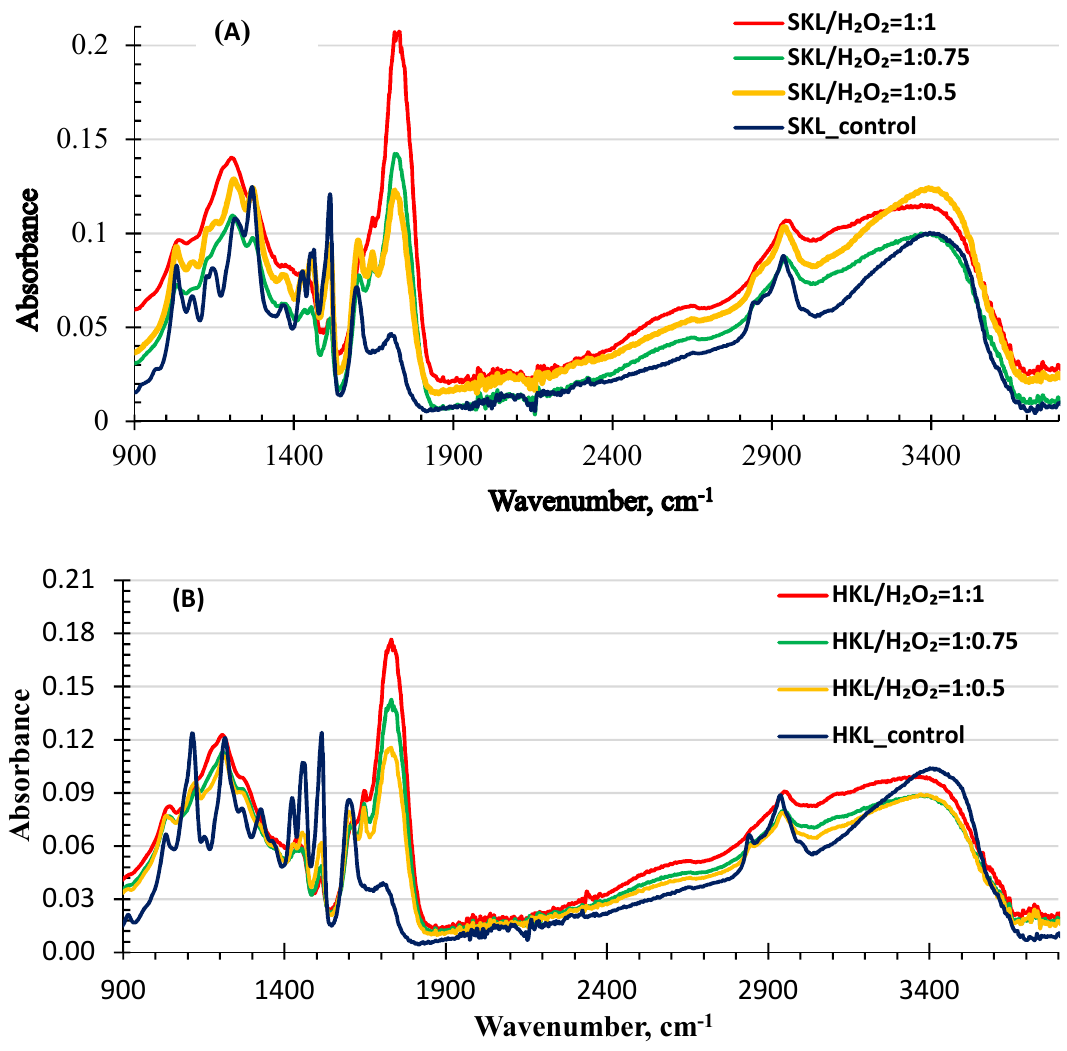
Figure 3. FTIR spectra of the original SKL ( A ), HKL ( B ), and depolymerized lignin products produced at various lignin/H 2 O 2 mass ratios (1:1, 1:0.75 and 1:0.5).